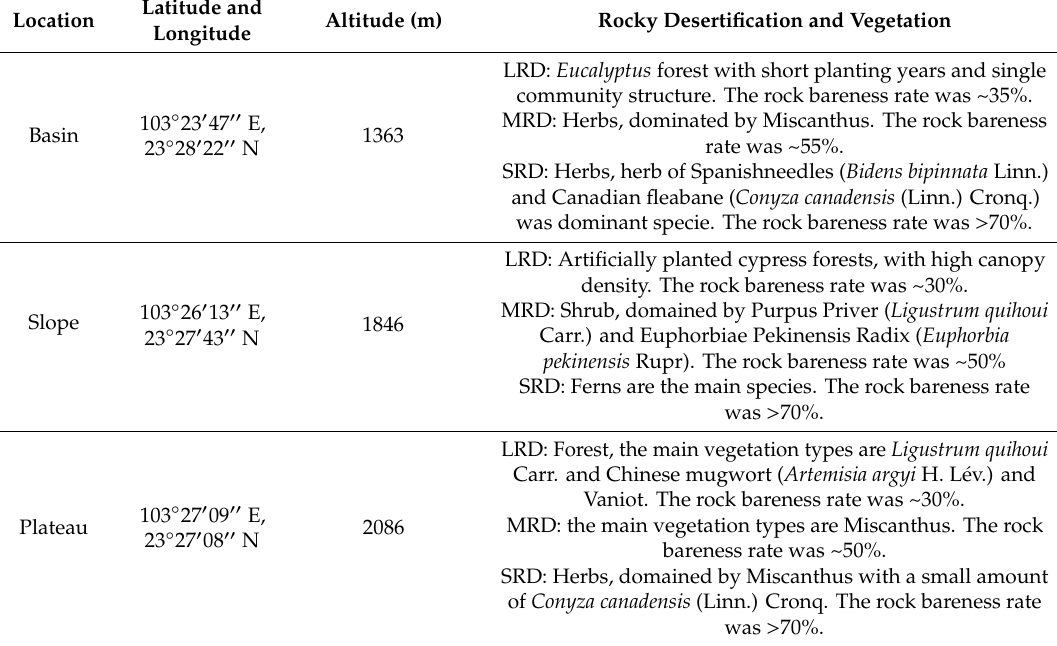
Table 1. Basic information of the study area and sampling